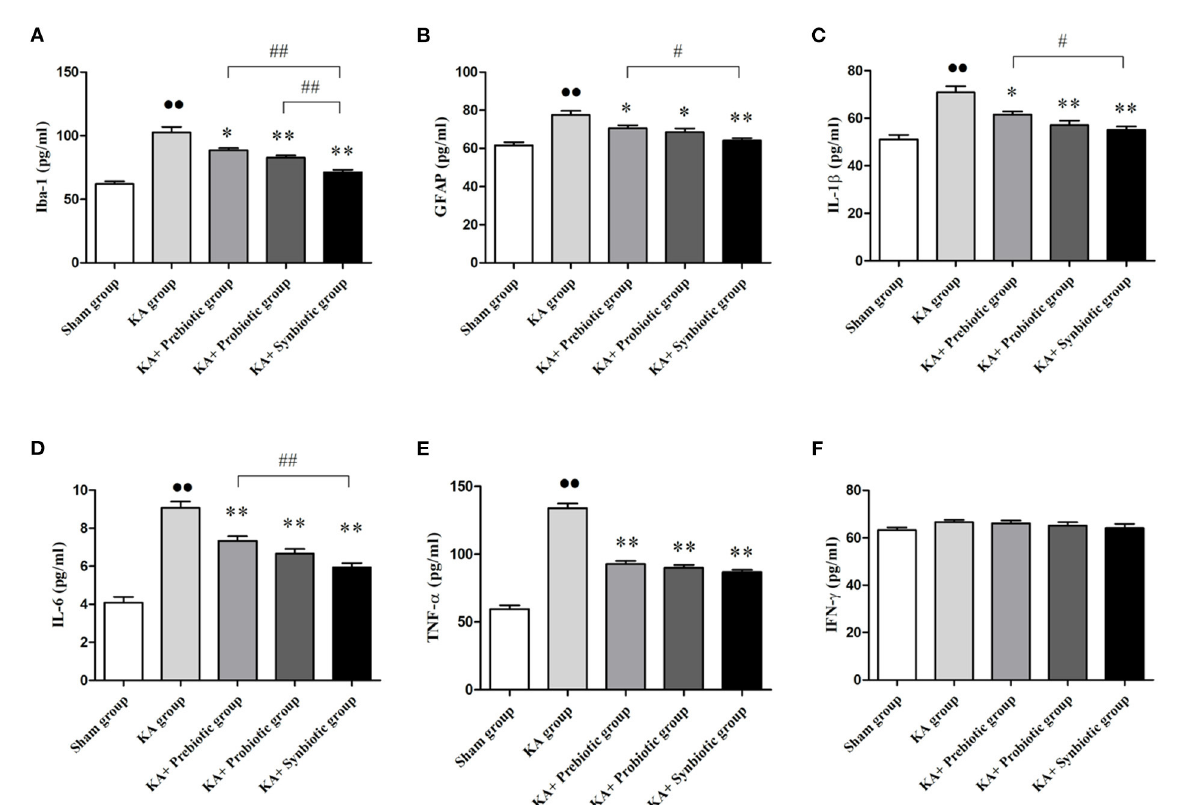
FIGURE4 Treatment with prebiotics, probiotics, and synbiotics decreased the levels of Iba-1 and GFAP and inhibited the release of inflammatory cytokines such as IL-1 β , IL-6, and TNF- α . (A) Iba-1. (B) GFAP. (C) IL-1 β . (D) IL-6. (E) TNF- α . (F) IFN- γ . •• P < 0.01 vs. the Sham group, * P < 0.05 vs. the KA group, ** P < 0.01 vs. the KA group, ## P < 0.01 vs. the KA + synbiotic group. KA, kainic